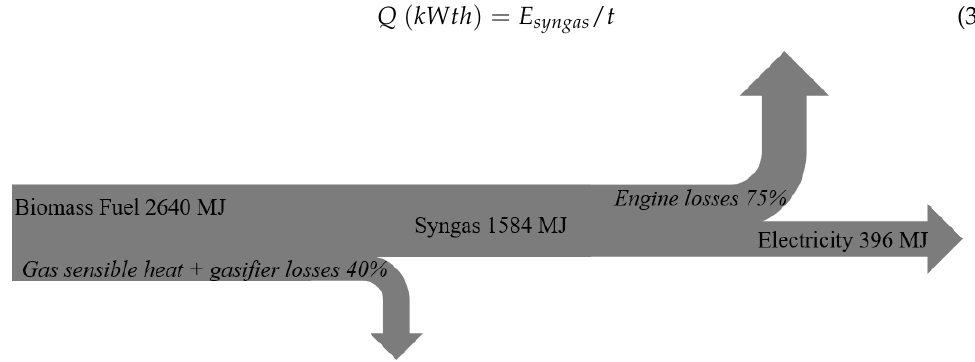
Figure 6. The energy conversion from biomass to electricity use, with the gasification yield estimated at 60% of efficiency (equivalent to 40% of losses) and the engine yield taken at 25% of efficiency (equivalent to 75% losses).